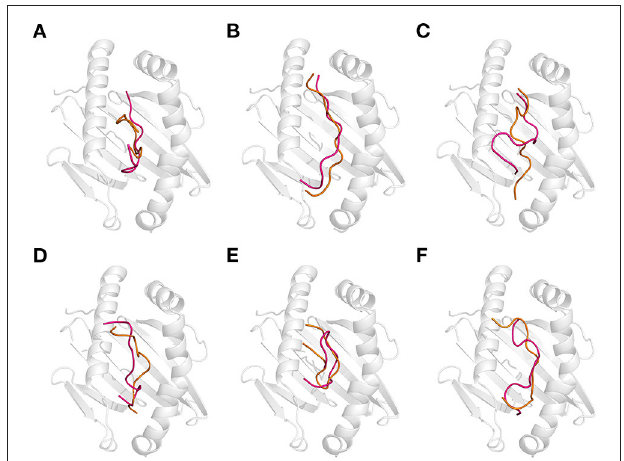
FIGURE 5 | Effect of the combination of thermal and acidic treatments on the recognition of gluten epitope peptides (GEPs). In each panel, the white cartoon representation presents the HLA-DQ2 with the epitope presenting groove facing outwards. The ribbon diagram represents each GEP. The hot pink ones represent the thermal treated one at pH 7.5 and 100 ◦ C followed by acidic treatment at pH 2.0 and 25 ◦ C. The orange ones represent the simultaneous thermal and acid-treated ones at pH 2.0 and 100 ◦ C. (A–F) GEP1–GEP6,